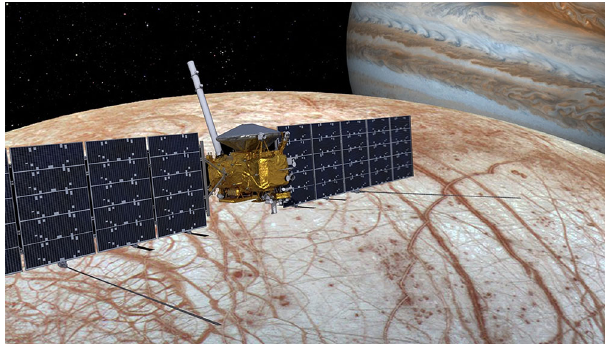
Fig. 2 The Europa Clipper spacecraft. This computer-aided design view shows the present con fi guration of the spacecraft. Two arrays of solar panels extend outward from the spacecraft bus. Extending perpendicular to the solar arrays are the integrated ice-penetrating radar antennas. The silver dome is the primary communication antenna, and the boom extending upward from the spacecraft hosts the magnetometer sensors. The remaining scienti fi c instruments are integrated onto the